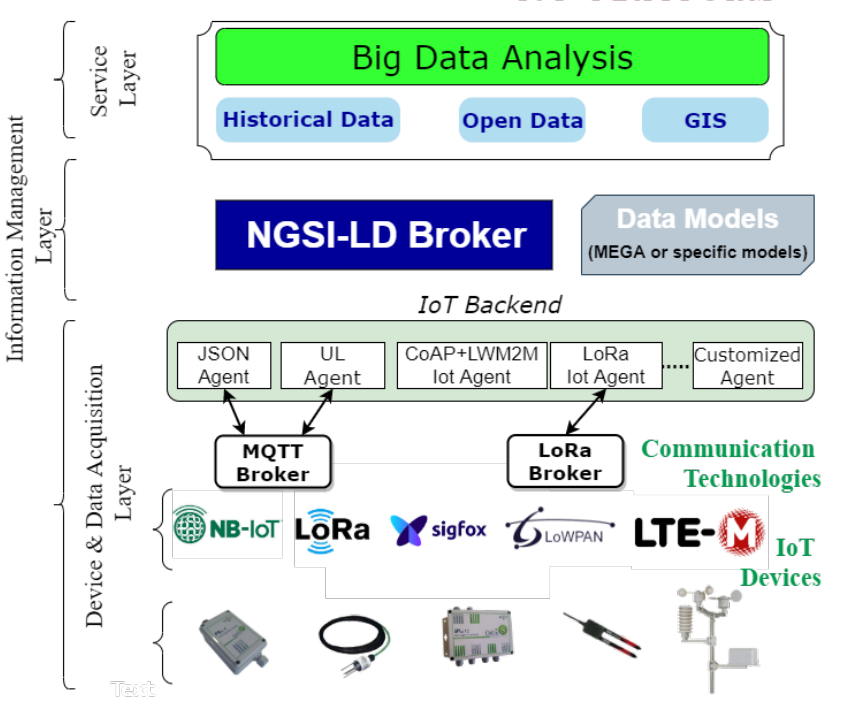
Figure 2. General vision of the proposed